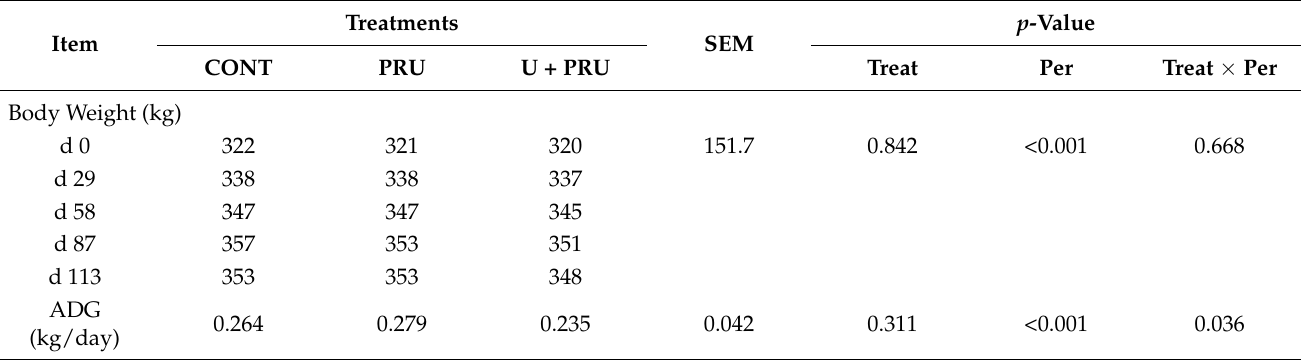
Table 8. Performance of Nellore young bulls, as a function of the use of post-ruminal urea and conventional urea during the dry season.